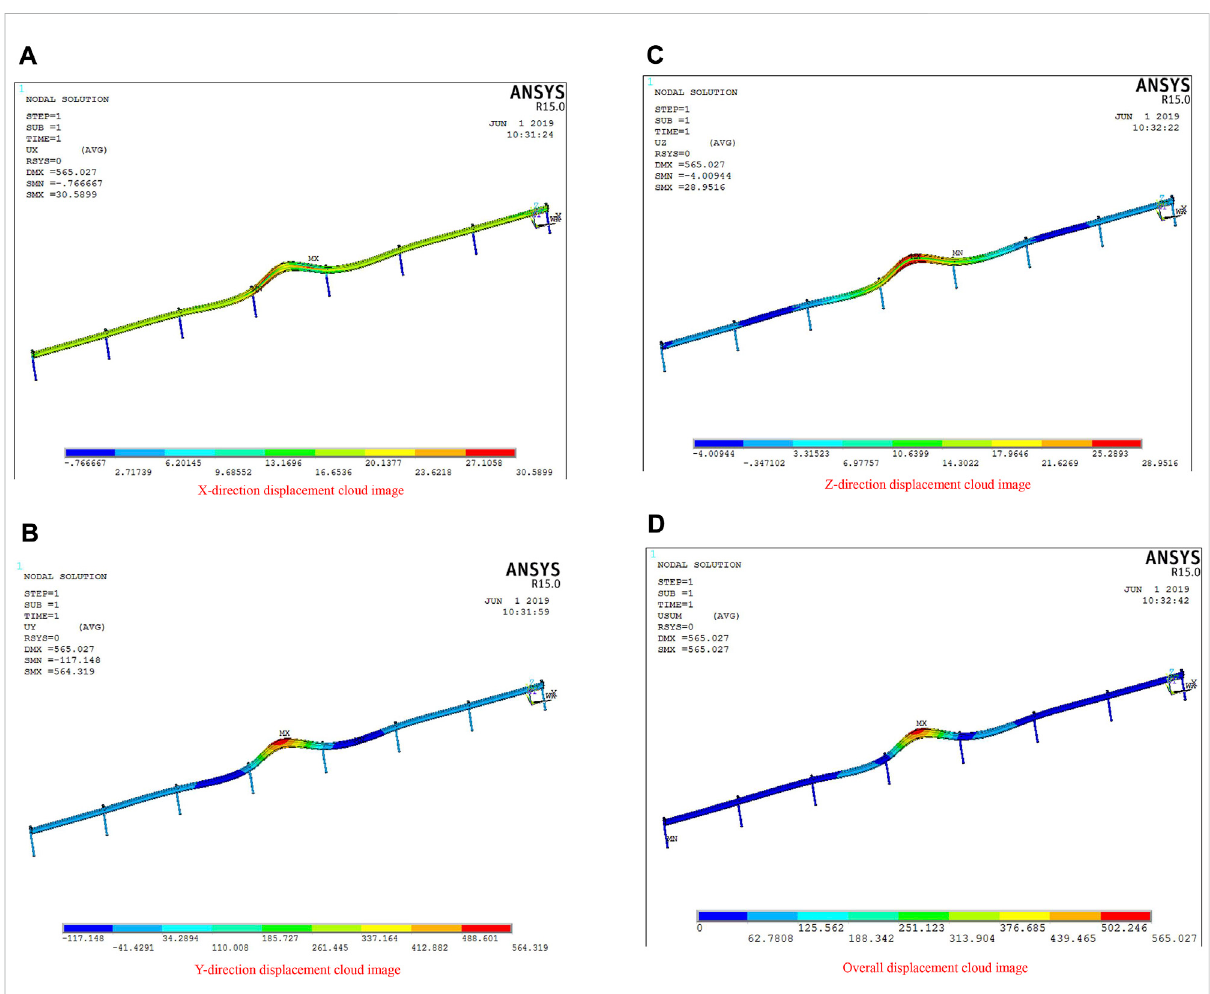
FIGURE 8 Displacementclouddiagramofathree-wavebeamsteelguardrail(impactedbythe55-tHGVatthespeedof65 km/hfromanangleof20 ° ,the concrete-embedded post). (A) : X-direction displacement cloud image of three-wave beam steel guardrail. (B) : Y-direction displacement cloud image of three-wave beam steel guardrail. (C) : Z-direction displacement cloud map of three-wave beam steel guardrail. (D) : Overall displacement cloud image of three-wave beam steel